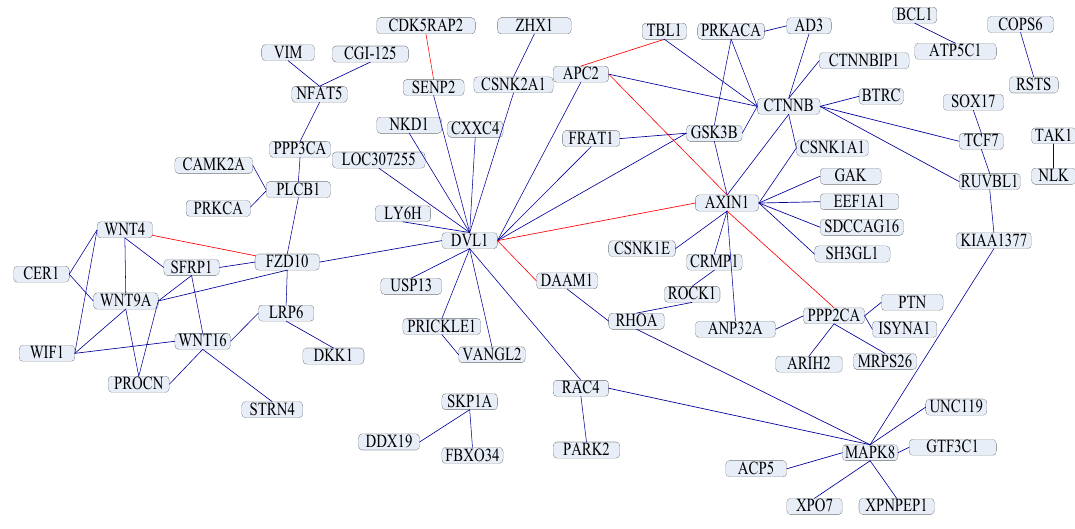
Figure 1. A crossover network for the Wnt-related